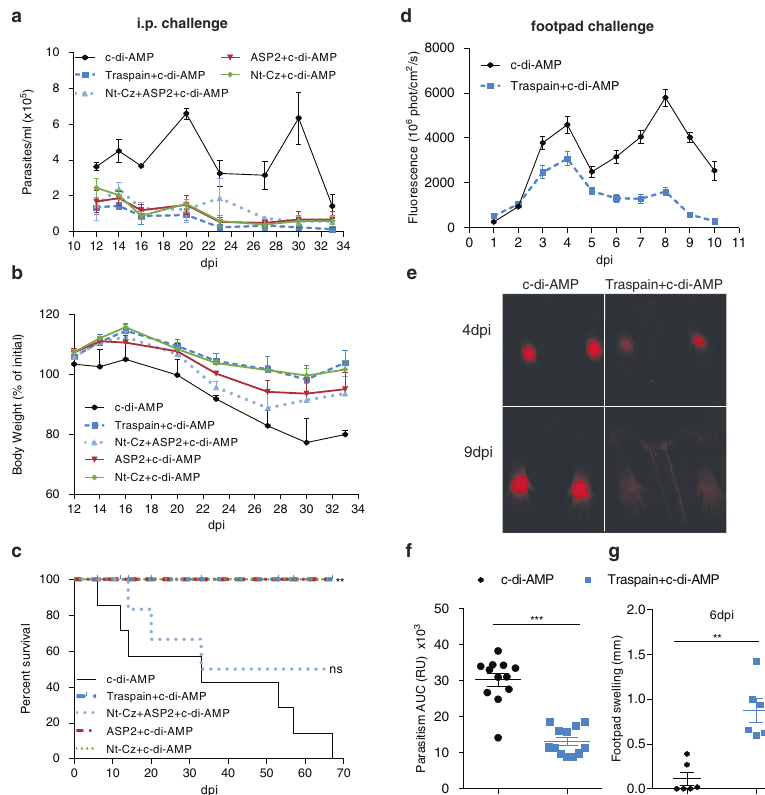
Fig. 6 Vaccine ef fi cacy during the acute phase of T. cruzi infection. Vaccinated C3H mice were challenged 30 days after the last dose with a lethal intraperitoneal (i.p.) dose of T. cruzi RA strain trypomastigotes and analyzed for: parasitemia ( a ), body weight loss ( b ) and survival ( c ), n = 6 per group, ** p < 0.01, Log-Rank Test, ns: not signi fi cant vs. control. Footpad challenge of the indicated groups with trypomastigotes of the CL-tdTomato strain. Mean fl uorescence intensity of feet determined by in-vivo imaging, between 1 and 10 dpi ( d ). Representative images from 4 to 9 dpi showing the control of parasite replication at the site of infection in vaccinated animals ( e ). Area under the curve of fl uorescence per site of infection ( n = 12) ( f ). Footpad swelling at 6 dpi ( g ). Footpad diameter was measured using a caliper. Data show the mean difference between day 0 and 6 per mouse. ** P < 0.01, *** p < 0.001, Mann – Whitney test. The results are representative of at least three independent